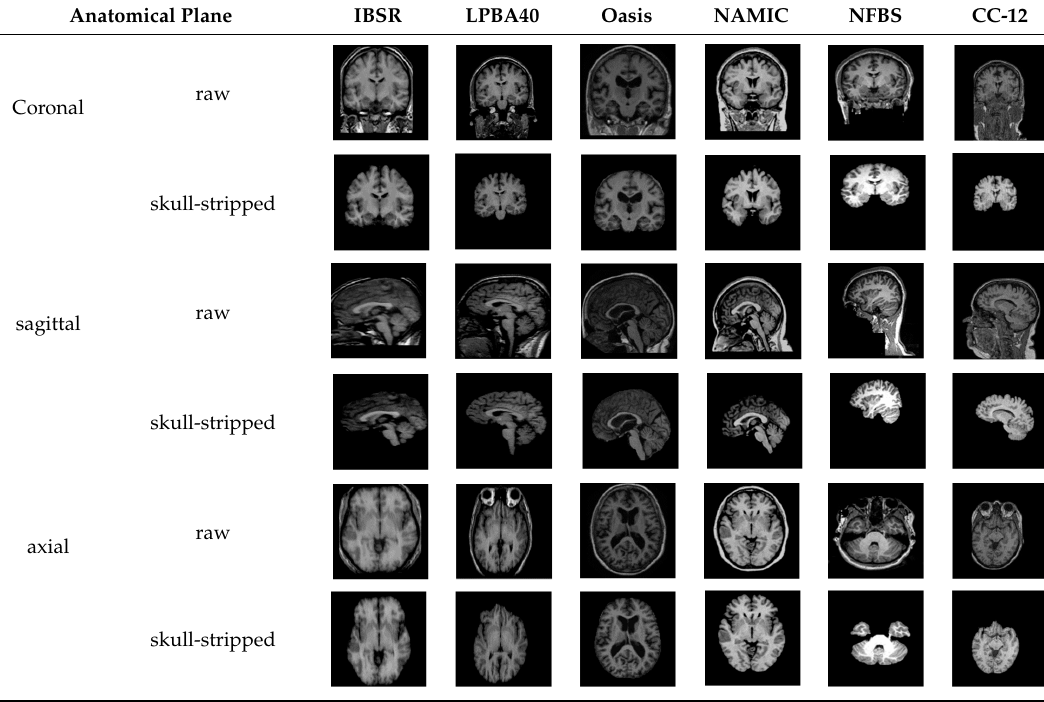
Table 2. Figures visualizing anatomical planes of publicly available datasets.